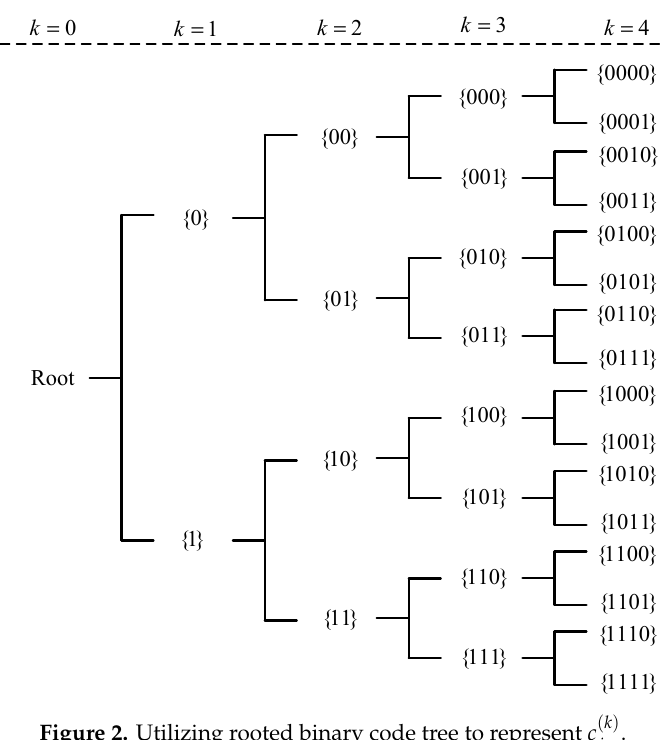
Figure 2. Utilizing rooted binary code tree to represent 𝑐 (cid:3037)((cid:3038)) .